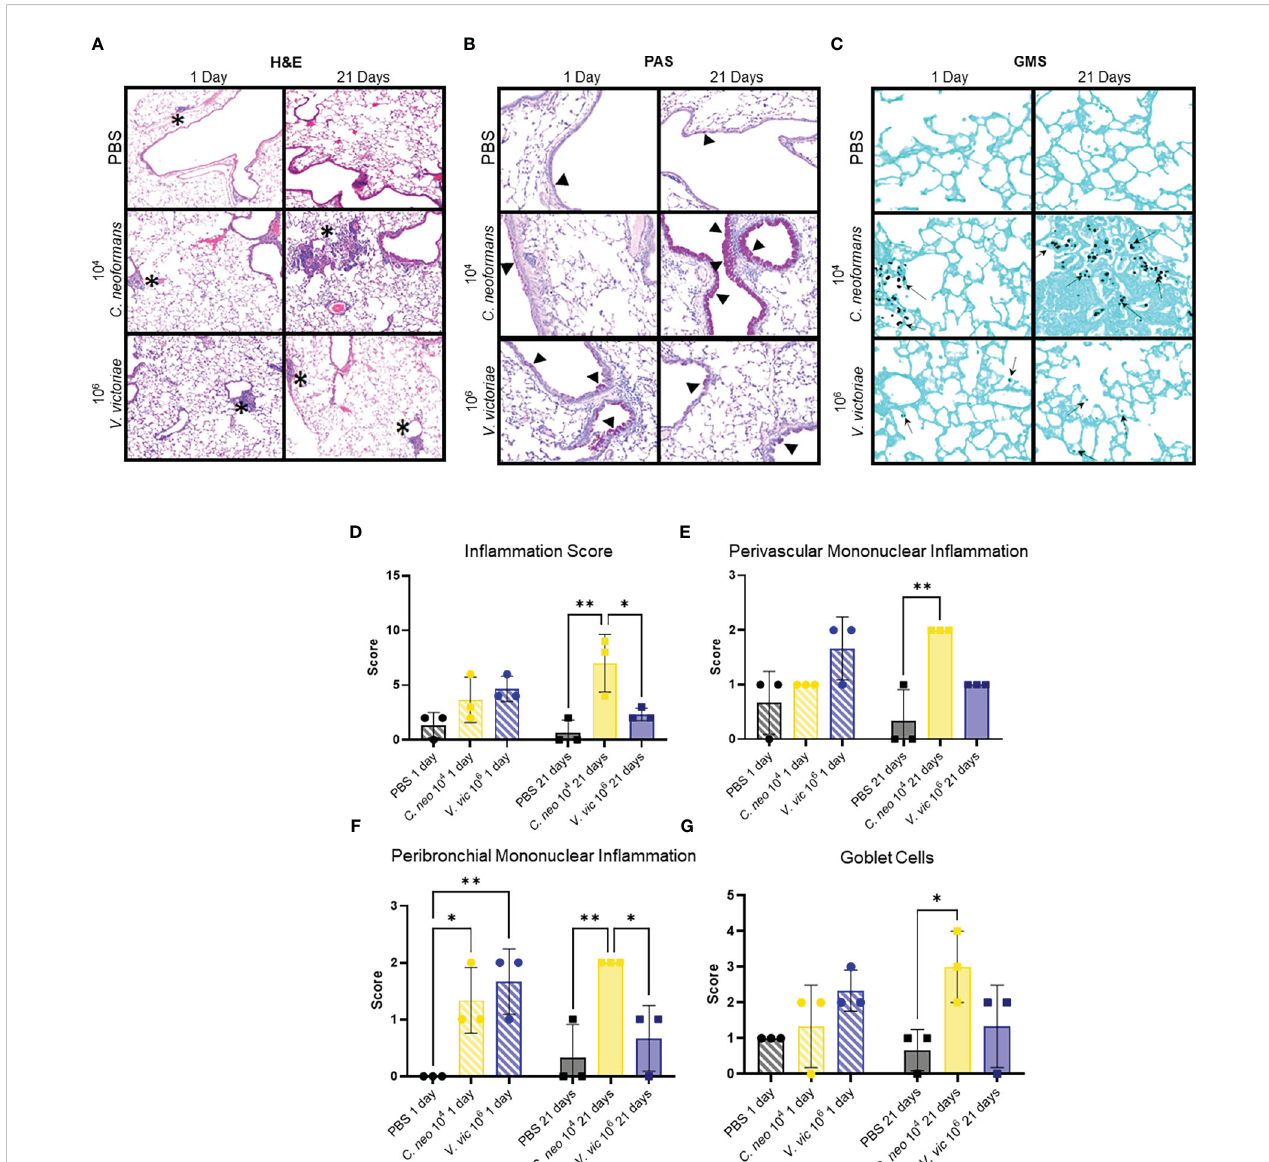
FIGURE 2 C. neoformans -induced in fl ammation worsens over time, whereas V. victoriae -induced in fl ammation resolves. (A – C) Representative micrographs of stained lung sections from mice one day (left) or 21 days (right) following repeated exposure to PBS (top), 10 4 C. neoformans (middle), or 10 6 V. victoriae cells (bottom). (A) H&E stain, 100x magni fi cation. (B) PAS-stain, 200x magni fi cation. (C) GMS-stain, 400x magni fi cation. (D) In fl ammation, (E) Perivascular Mononuclear In fl ammation, (F) Peribronchial Mononuclear In fl ammation and (G) Goblet Cells histology scores of lungs following repeated exposure to PBS (black), 10 4 C. neoformans cells (yellow) or 10 6 V. victoriae cells (blue) at 1 day post fi nal exposure (circles, crossed bars, left) or 21 days post fi nal exposure (squares, solid bars, right). n=3 per group, *P<0.05, **P < 0.01. P values were determined by ordinary one-way ANOVA with Tukey ’ s multiple comparisons test comparing each exposure together for the same